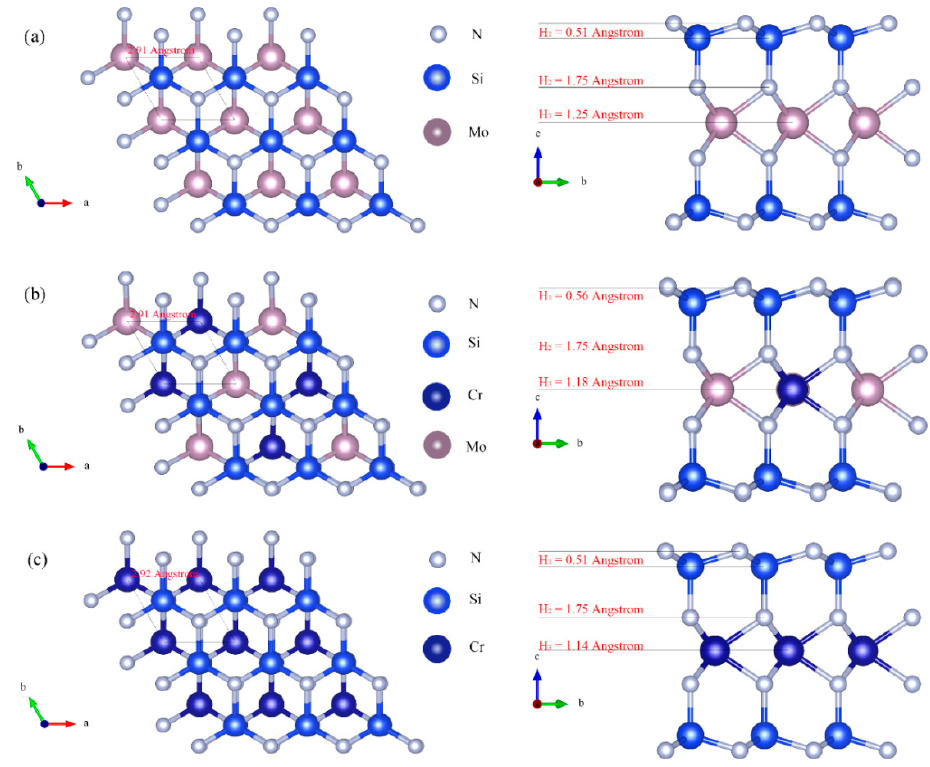
Figure 1. Top (up) and Side (down) views of the optimized geometry for ( a ) MoSi 2 N 4 , ( b ) Mo 0.5 Cr 0.5 Si 2 N 4 and ( c ) CrSi 2 N 4 monolayers. Gray, blue, light magenta and navy blue represent Si, N, Mo and Cr atoms, respectively. The black diamonds represent the unit cells in our calculations. Then, the density of states, orbital information and energy band structures of 2D MoSi 2 N 4 , Mo 0.5 Cr 0.5 Si 2 N 4 and CrSi 2 N 4 are plotted in Figure 2. As presented in Figure 2a ,